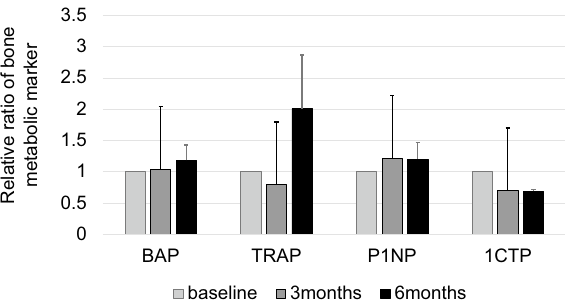
Figure 4. The relative ratio of bone metabolic markers obtained from 12 patients the next day (baseline), 3 months, and 6 months after surgery. The results are presented as the mean, and the bars indicate standard